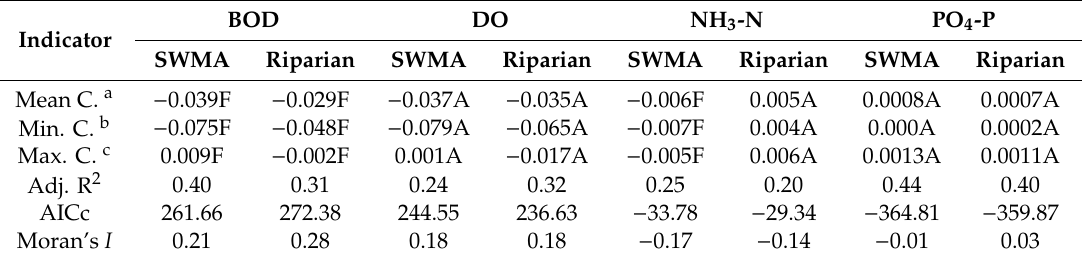
Table 4. Estimated GWR models for BOD, DO, NH 3 -N, and PO 4 -P at SWMA and riparian scales. The higher value of R 2 and lower values of AICc and Moran’s I (absolute value) indicate better performance of the estimated models.